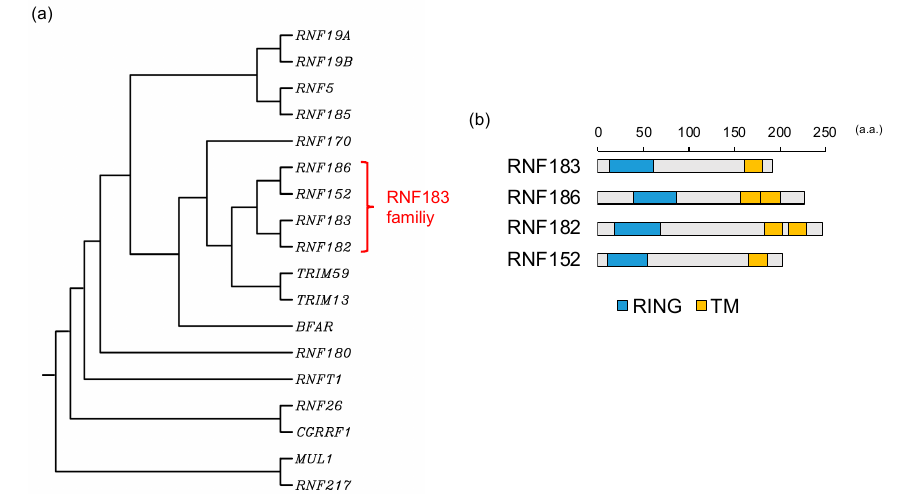
Figure 1. RNF183 family: ( a ) The phylogenetic tree for C3H2C3-RING E3s with transmembrane. Protein sequences for E3s were aligned with a multiple sequence alignment using the CLUSTALW (http://www.genome.jp/tools/clustalw); ( b ) The comparison of the domain structures of the RNF183 family. Information on the domain structure of RNF183 family protein was obtained from UniProt (https://www.uniprot.org) for RNF183 (Q96D59), RNF186 (Q9NXI6), RNF182 (Q8N6D2), and RNF152 (Q8N8N0). RING, C3H2C3-RING domain; TM, transmembrane domain; a.a., amino acids.